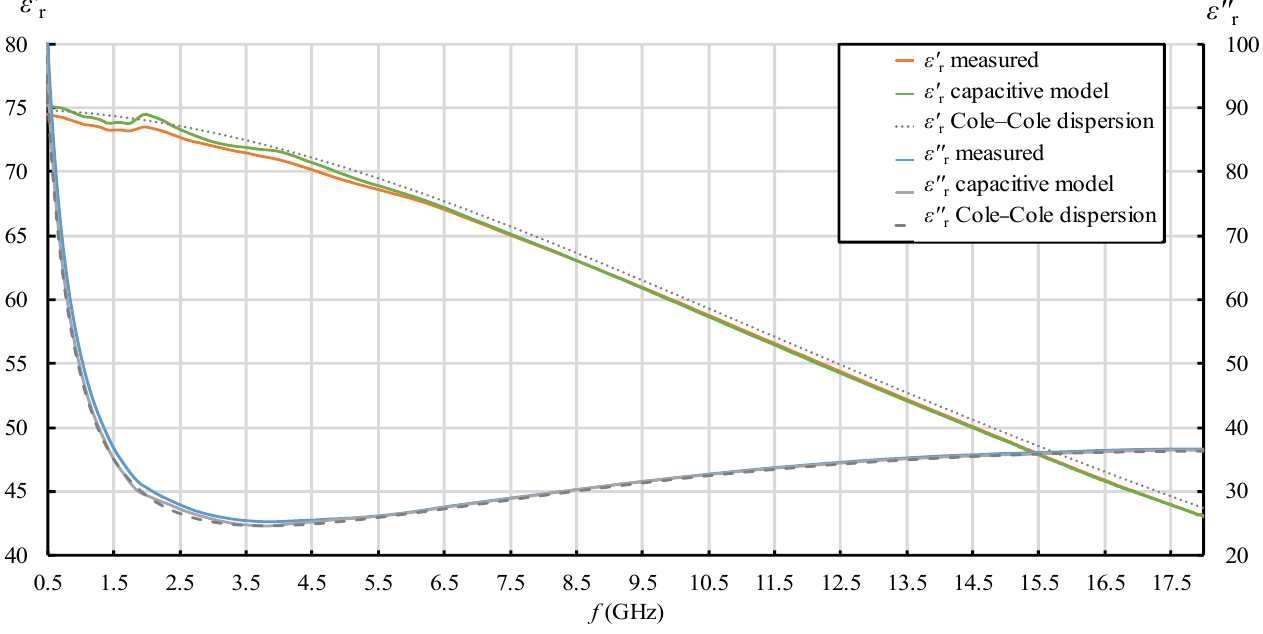
Figure 8. ε (cid:48) r and ε (cid:48)(cid:48) r for 0.25M saline: measurement result as a final value obtained from the measure- ment software (“measured”); measurement result obtained by postprocessing the reflection coefficient using the simple capacitive-load model (“capacitive model”) and dispersion model (“Cole–Cole dispersion”).